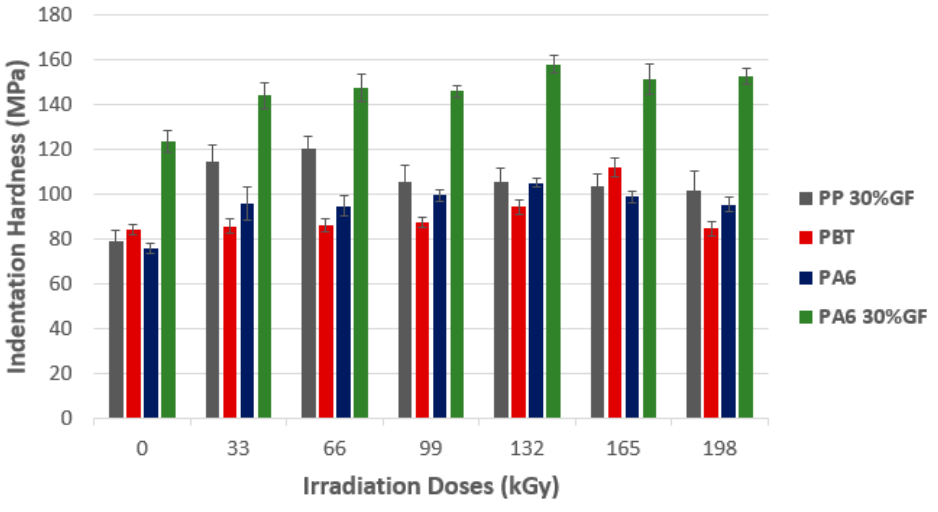
Figure 11. Indentation hardness ( H IT )—Technical polymers.